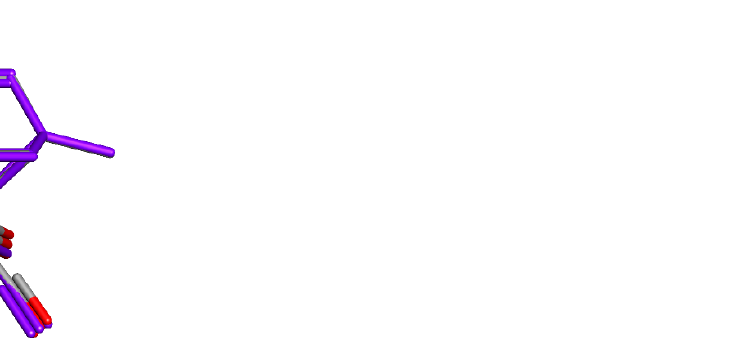
Figure 3. Overlay of the geometry from the X-ray crystal structure (purple) with the PBE0/BS1 optimized structure of (TMCOT)Cr(CO) 3 . Cr: green, O: red, C: grey (H omitted for clarity).